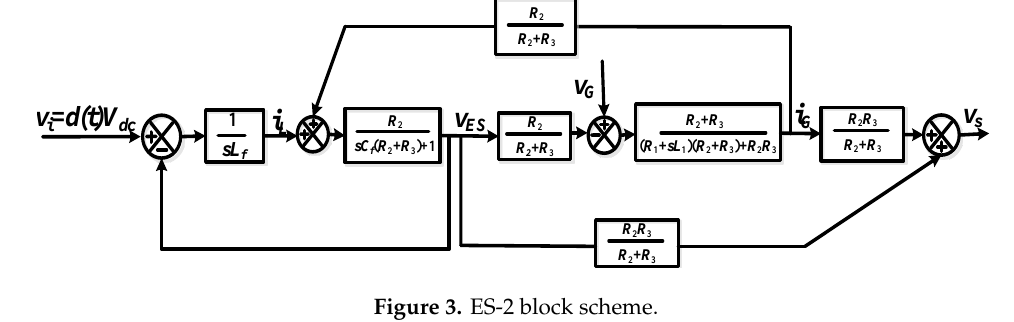
Figure 3. ES-2 block scheme.